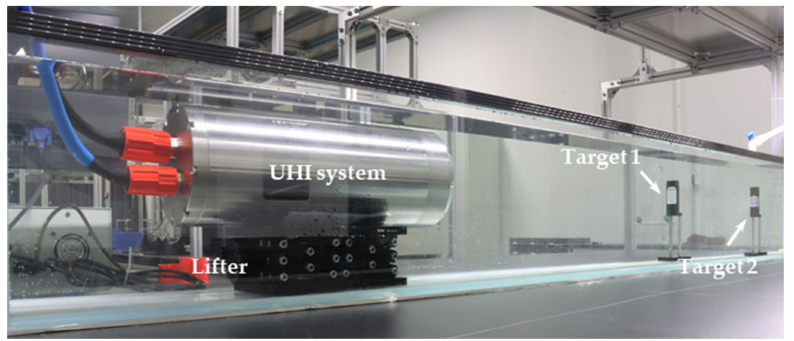
Figure 9. The experimental setup for the performance test of the focusing transfer method.